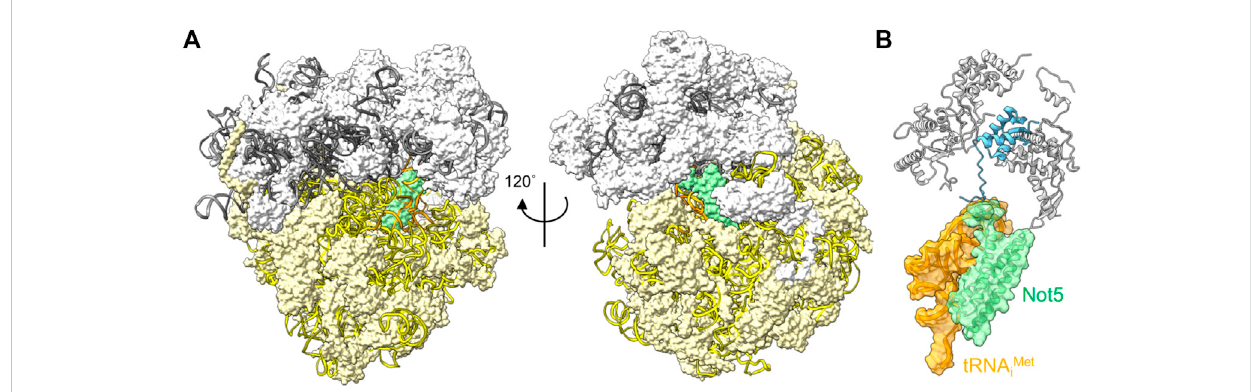
FIGURE 4 Interactions between theribosome and Ccr4-Not subunits. (A) Complex ofthe S.cerevisiae ribosome with an empty A-site, the N-terminal domain of Not5located inthe E-site (green), and tRNA i Met occupying the P-site (orange). The small 40S (white) and large 60S (light yellow) ribosome subunits are indicated; 18S rRNA (yellow); 5S, 5.8S and 25S rRNA (grey) are represented using ribbons. (B) Detail of the interactions of S. cerevisiae Not5 located in the E-site (green) with the tRNA i Met occupying the P-site (orange) and the small ribosome subunit S25 (blue). PDB entry 6TB3 (Buschauer et al.,